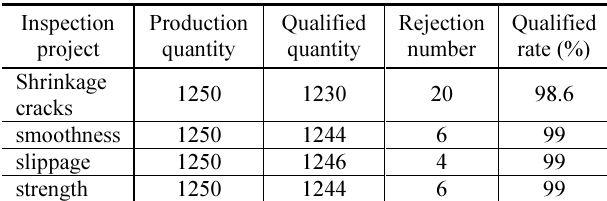
Table 5. Analysis of the investigation results